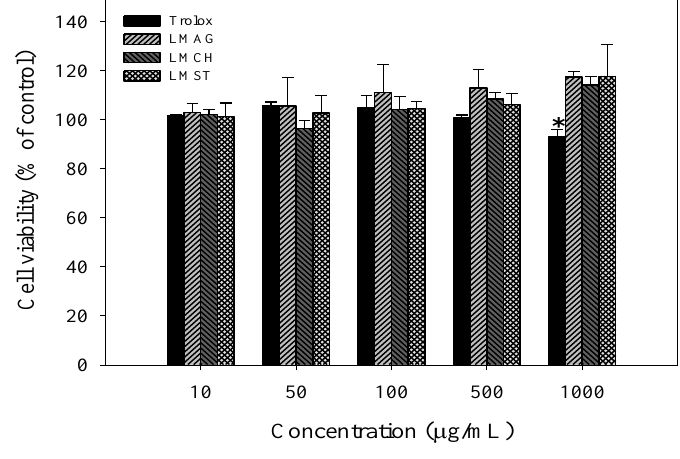
Figure 1. The cytotoxic effects of low-molecular-weight agar (LMAG), low-molecular-weight chitosan (LMCH), low-molecular-weight starch (LMST) and trolox on Hs68 cell viability. Data are expressed as mean values ± S.D. of triplicate experiments. * p < 0.05 (LM-polysaccharides vs.